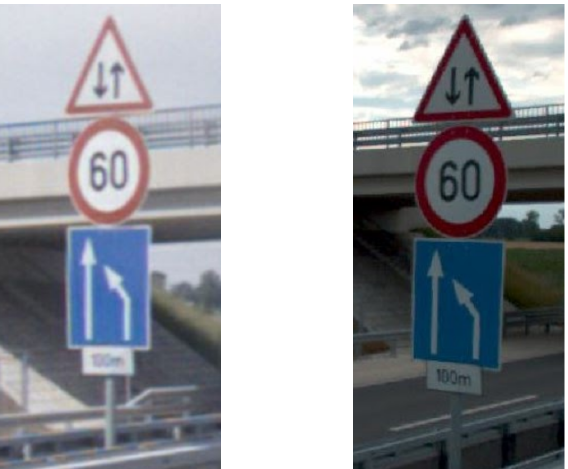
Figure 8. Shooting from the same spot ( left ): Leica Pegasus 2 Ultimate 360 ◦ panoramic photo crop, ( right ): Ladybug 5+ (Riegl) Camera Picture crop.